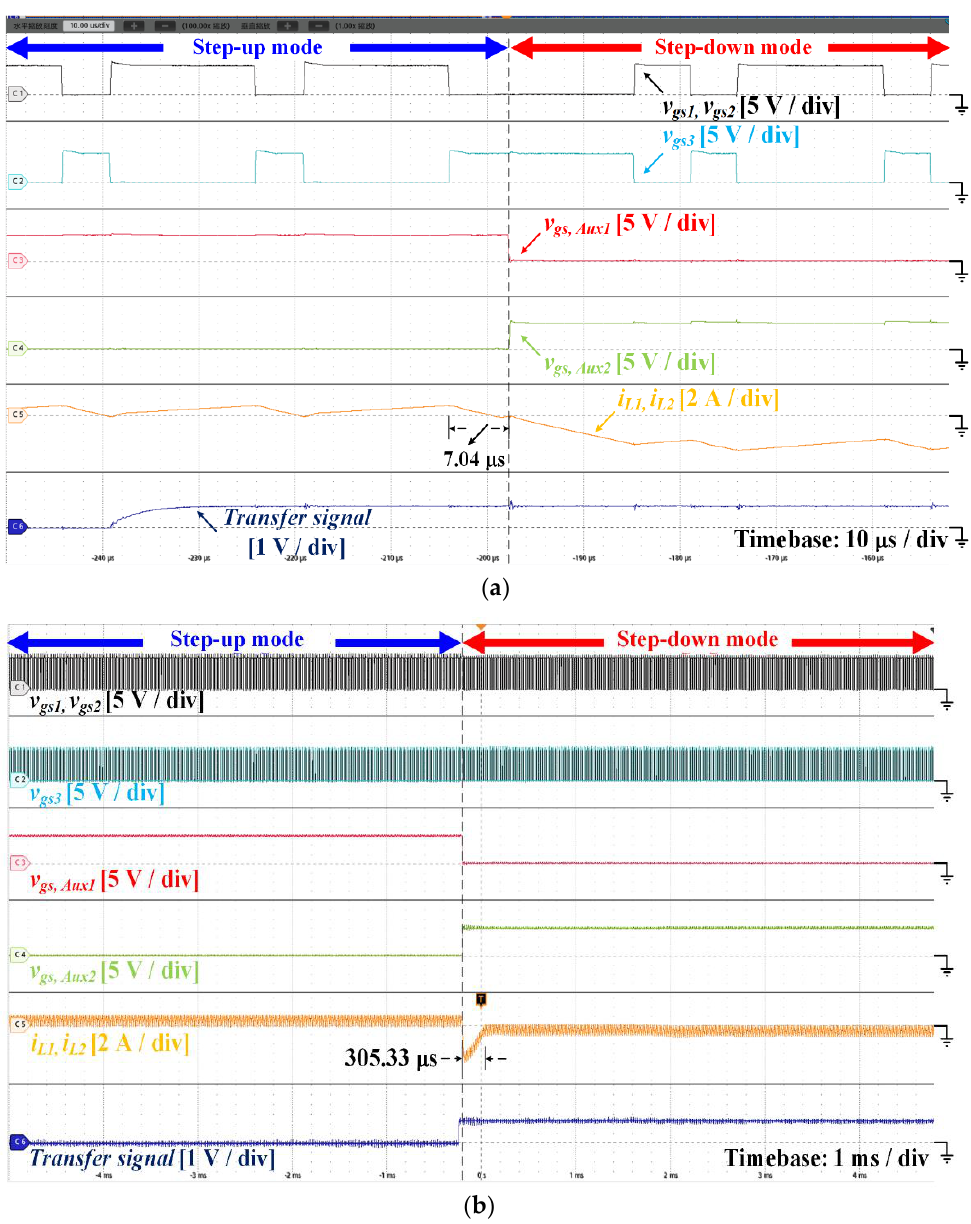
Figure 18. Experimental results of dynamic performances with BCM load condition. ( a ) v gs 1 , v gs 2 , v gs 3 , v gs , Aux1 , v gs , Aux2 , i L1 , i L2 , transfer signal. ( b ) Change from the step-up mode to the step-down mode .